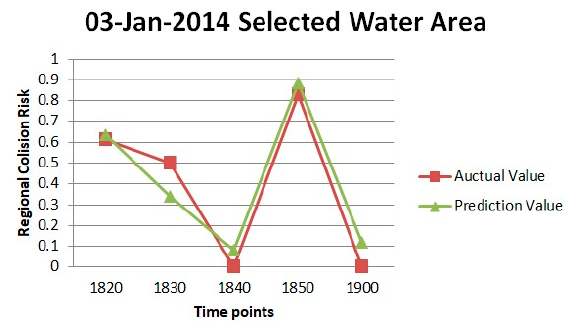
Figure 15. 03-Jan-2014 Regional collision risk.